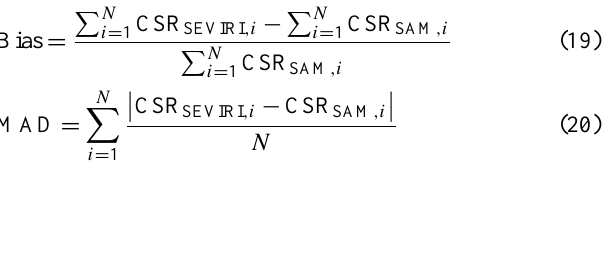
Fig. 10. Scatter plots for the shortened validation time series (May 2011–Jun. 2011). Left panel: CSR retrieved using “Baum v2.0”. Right panel: CSR retrieved using “Baum v3.5”. Filled circles indicate that the data pair has passed the manual cumulus cloud screening on the basis of all-sky images.